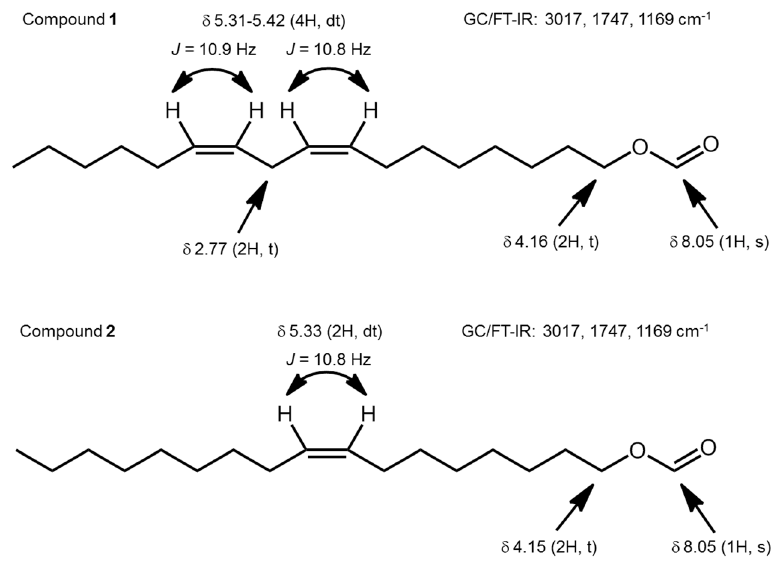
Figure 2. 1 H-NMR and GC/FT-IR analyses of natural compounds 1 and 2 .